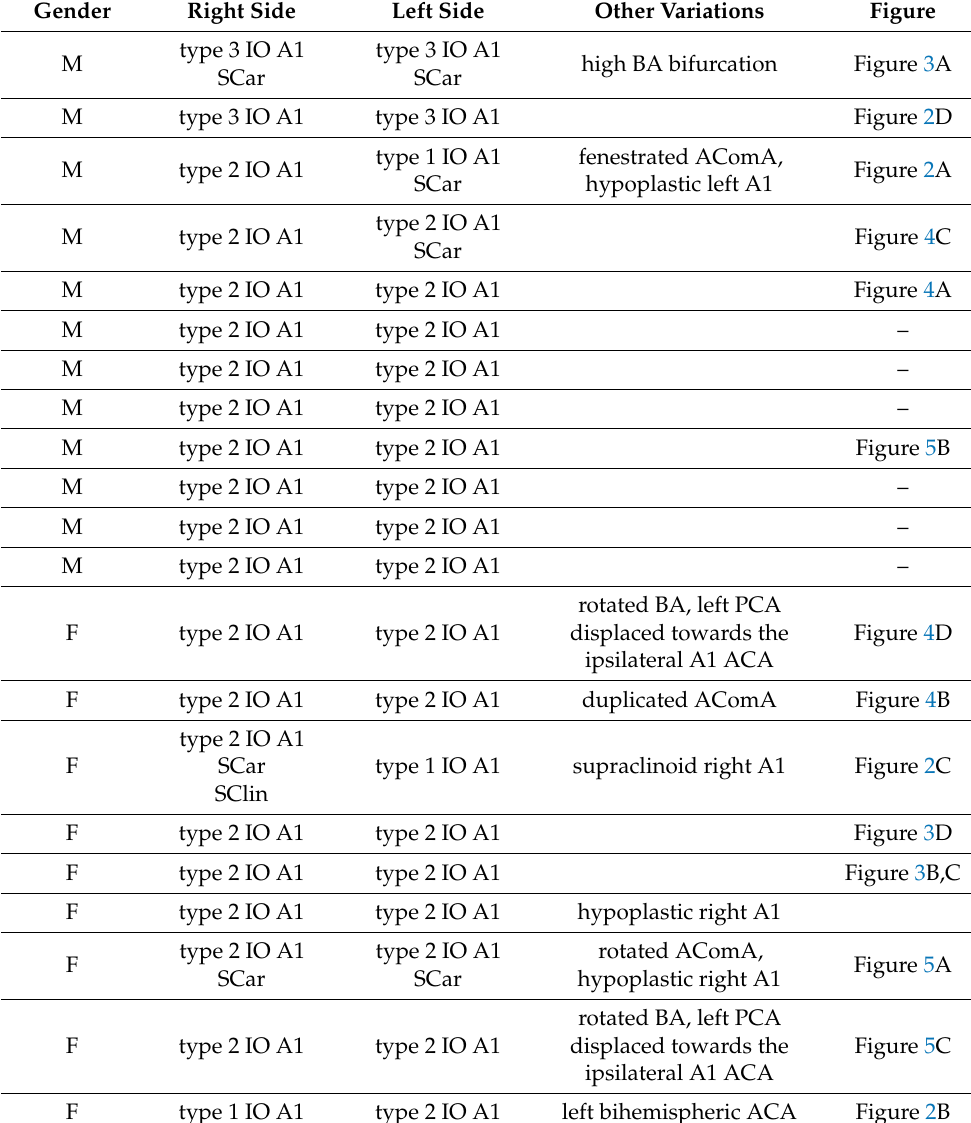
Table 1. Anatomical variation in cases with infraoptic courses of the A1 segment (IO A1) of the anterior cerebral artery (ACA). SCar: supracarotid course of the IO A1. SClin: supraclinoid course of the IO A1. AComA: anterior communicating artery. PCA: posterior cerebral artery. M: male. F: